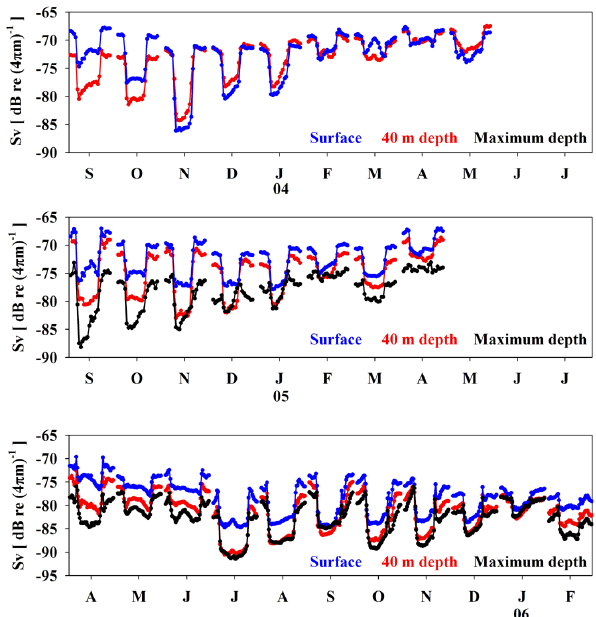
Fig. 7. Monthly mean daily cycle of backscatter strength values at different depths. Year is indicated below January